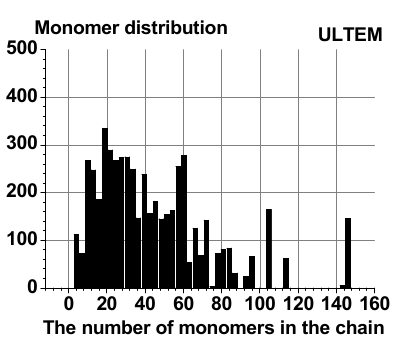
Figure 2. Density of the prepared samples sorted according to their increasing density, Ultem ( left ), PEI-304 ( right ). The bars indicate the standard deviation along the equilibrium trajectories.